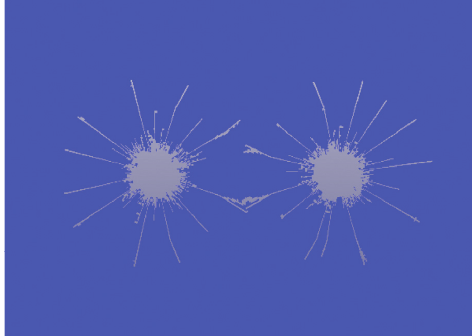
Figure 9: Crack penetration of ordinary blasting.